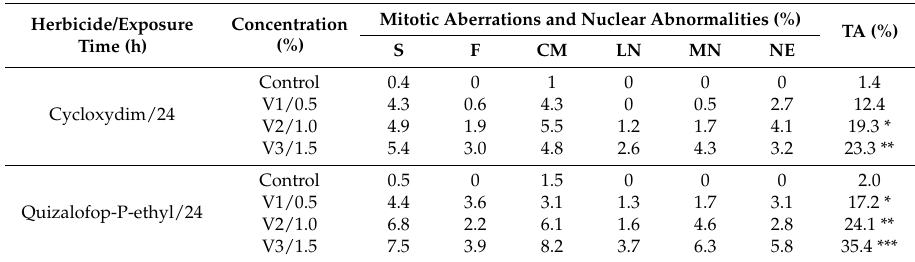
Table 2. Type and percentage of mitotic aberrations and nuclear abnormalities induced by some herbicides in the cells of A. cepa .